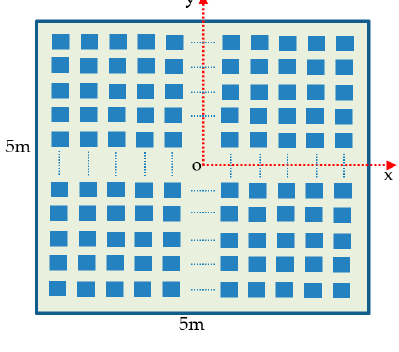
Figure 2. Fingerprints on the floor. Table 1. Visible Light Communication (VLC) parameters.